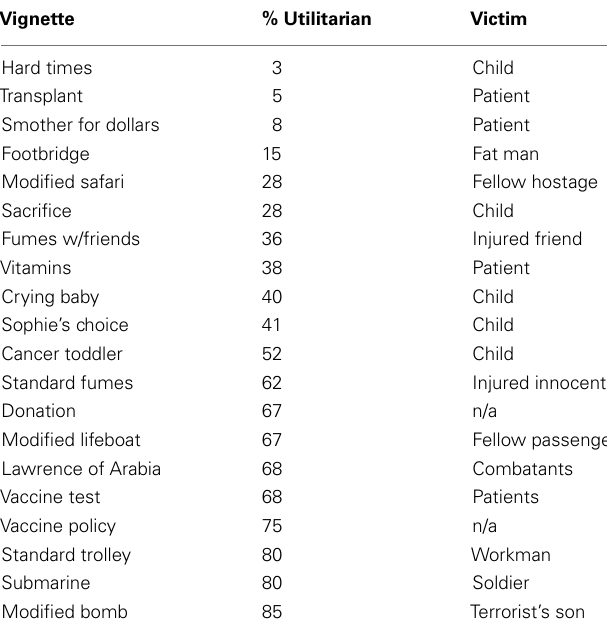
Table 2 |Victim characteristics of vignettes ranked according to % utilitarian